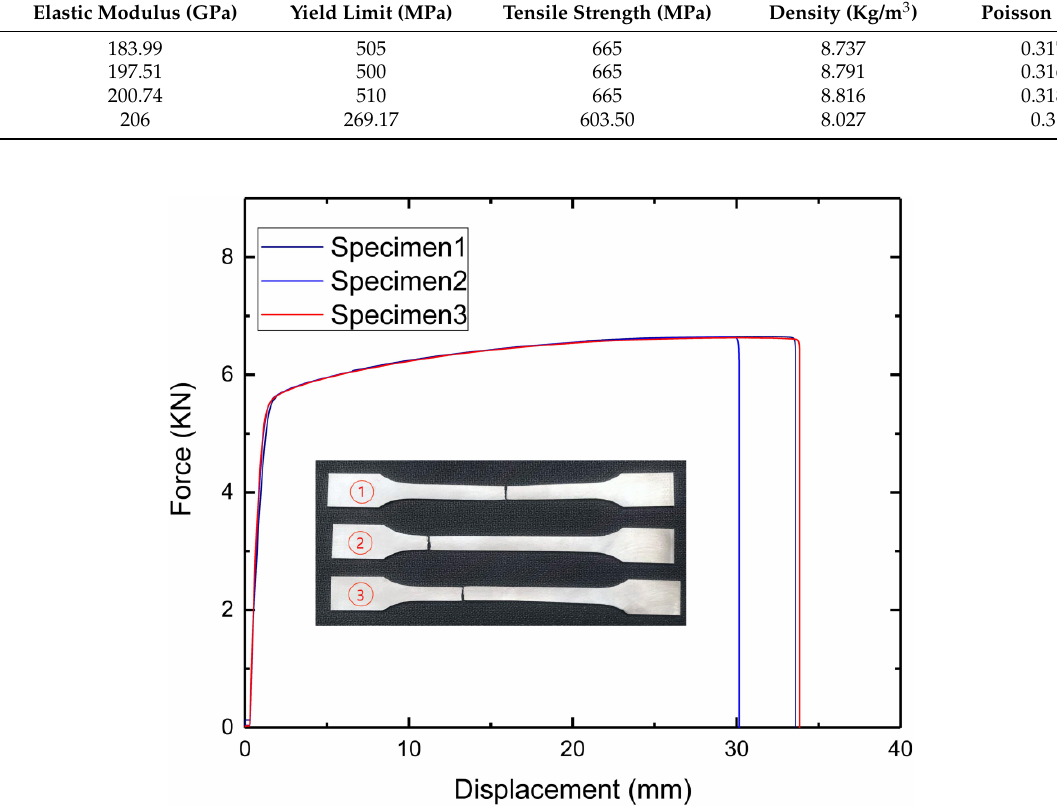
Figure 9. Uniaxial tensile test’s load–displacement